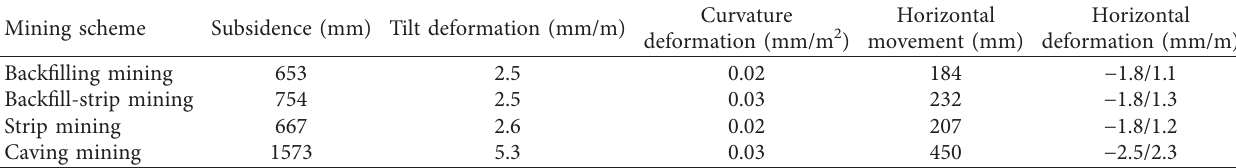
Table 7: The extreme values of surface movement and deformation after mining in each